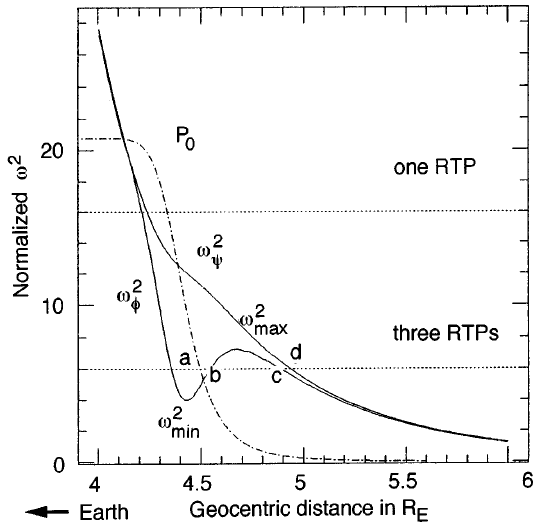
Fig. 13. Radial profiles of the ring current pressure P , and 0 frequencies relevant to the radial confinement of unstable drift Alfve´ n-ballooning modes (reproduction of Fig. 2 of Vetoulis and Chen, 1996). The dashed curve indicates the pressure. The traces labeled (cid:120) 2 and (cid:120) 2 are local eigenfrequencies associated with radial (cid:87) (cid:47) and azimuthal di(cid:128)erential operators. Depending on the frequency ( horizontal dotted line ) of the global mode, there can be up to three regular turning points ( RTPs or cuto(cid:128) points, a , b , and c ). There is always one singular resonant point (or a shear Alfve´ n resonance at point d , for example). The global mode can be trapped between the turning points a and